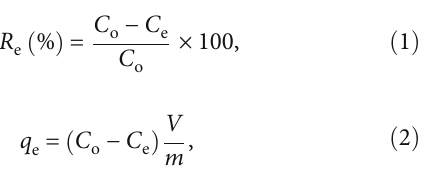
O @AJPL nanocomposite and its mechanism of adsorption-desorption behavior for MG dye 3 4